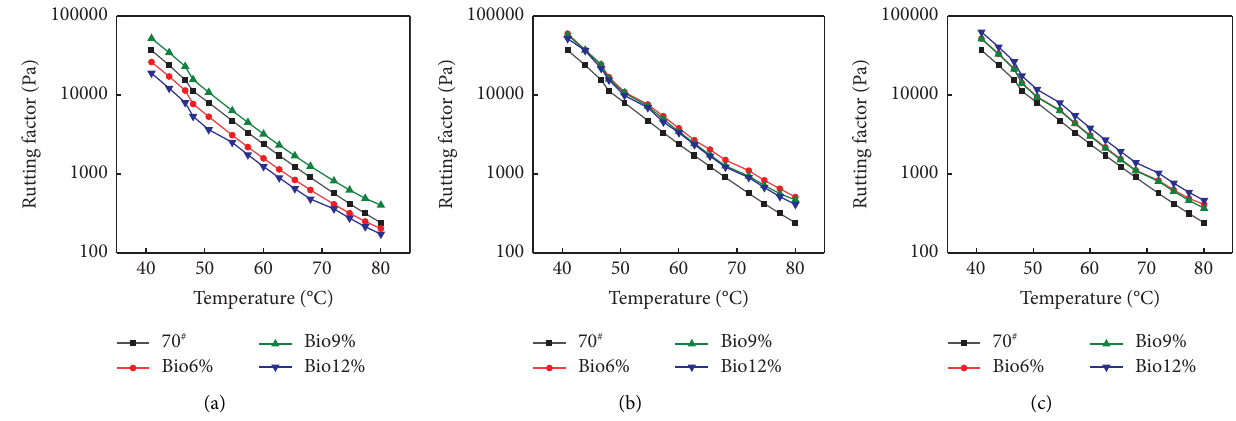
Figure 8: Te relationship between rutting factor and temperature: (a) 0% nano-Zno, (b) 1% nano-ZnO, and (c) 3%